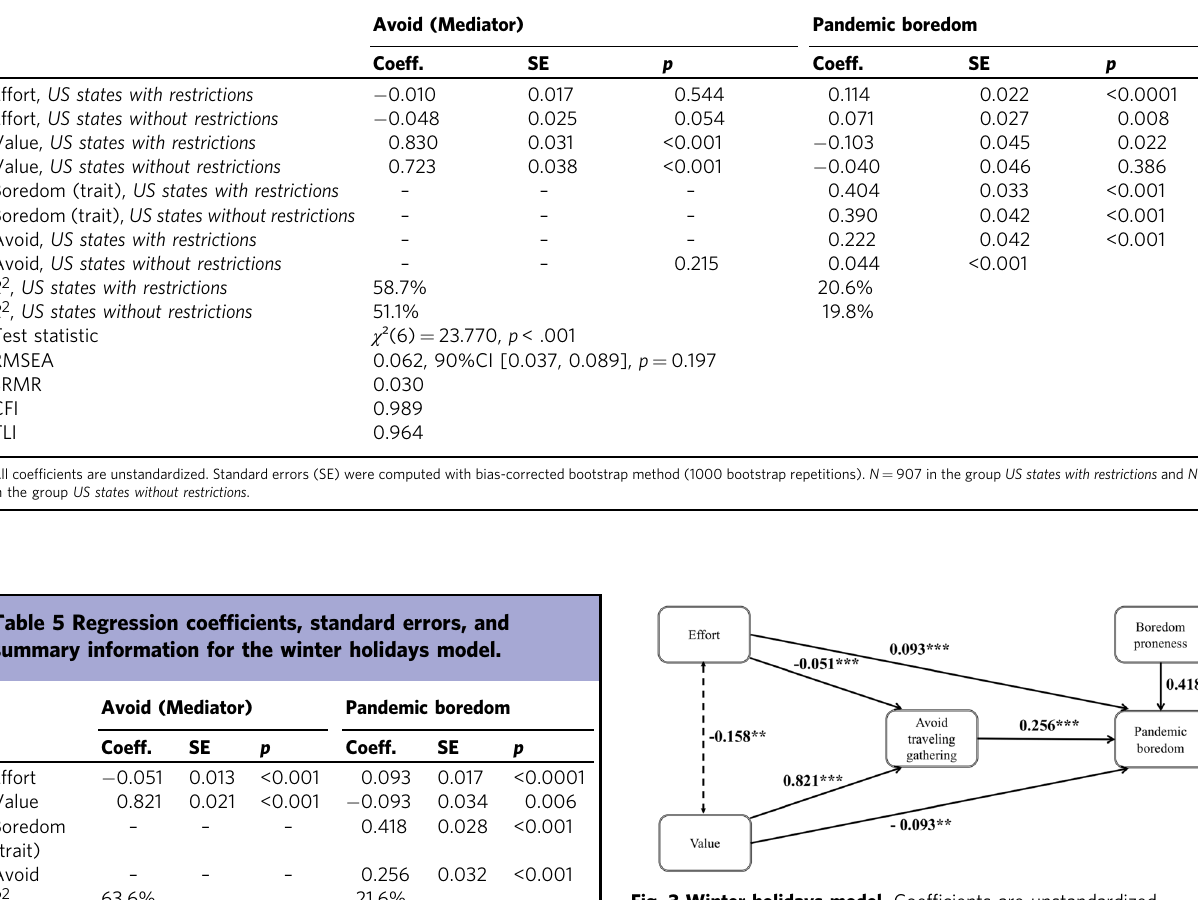
Fig. 3 Winter holidays model. Coef fi cients are